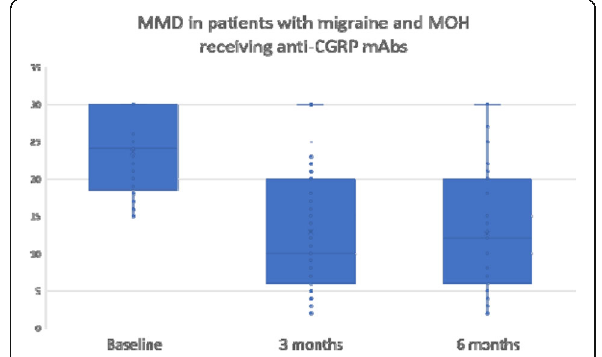
Fig. 1 (abstract P0297). See text for description